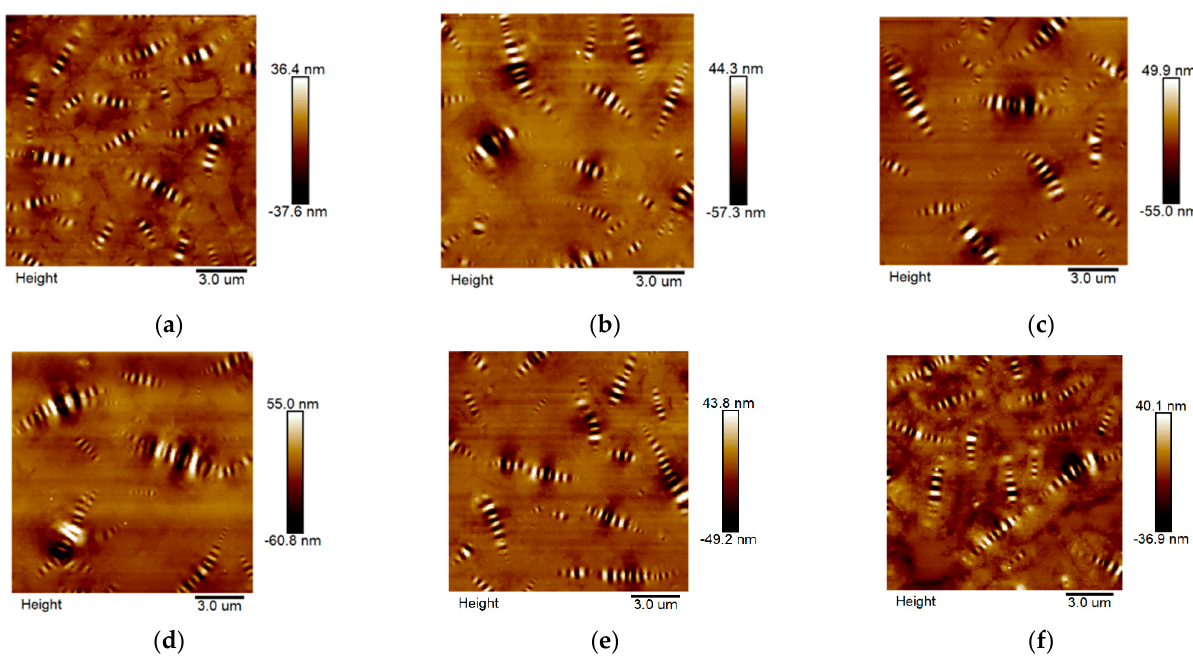
Figure 7. Micromorphology of asphalt binders: ( a ) RAB; ( b ) AA; ( c ) SRA; ( d ) ASRA; ( e ) RRA; ( f ) ARRA.